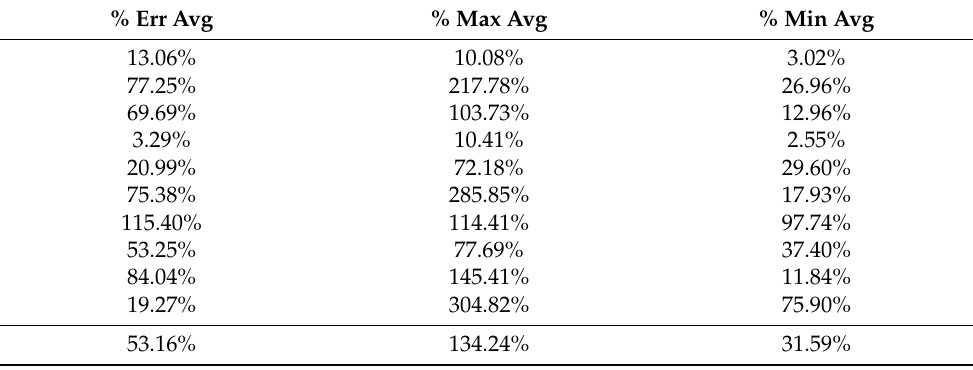
Table A134. Set 2, trials 31–40 data (actual PR value).